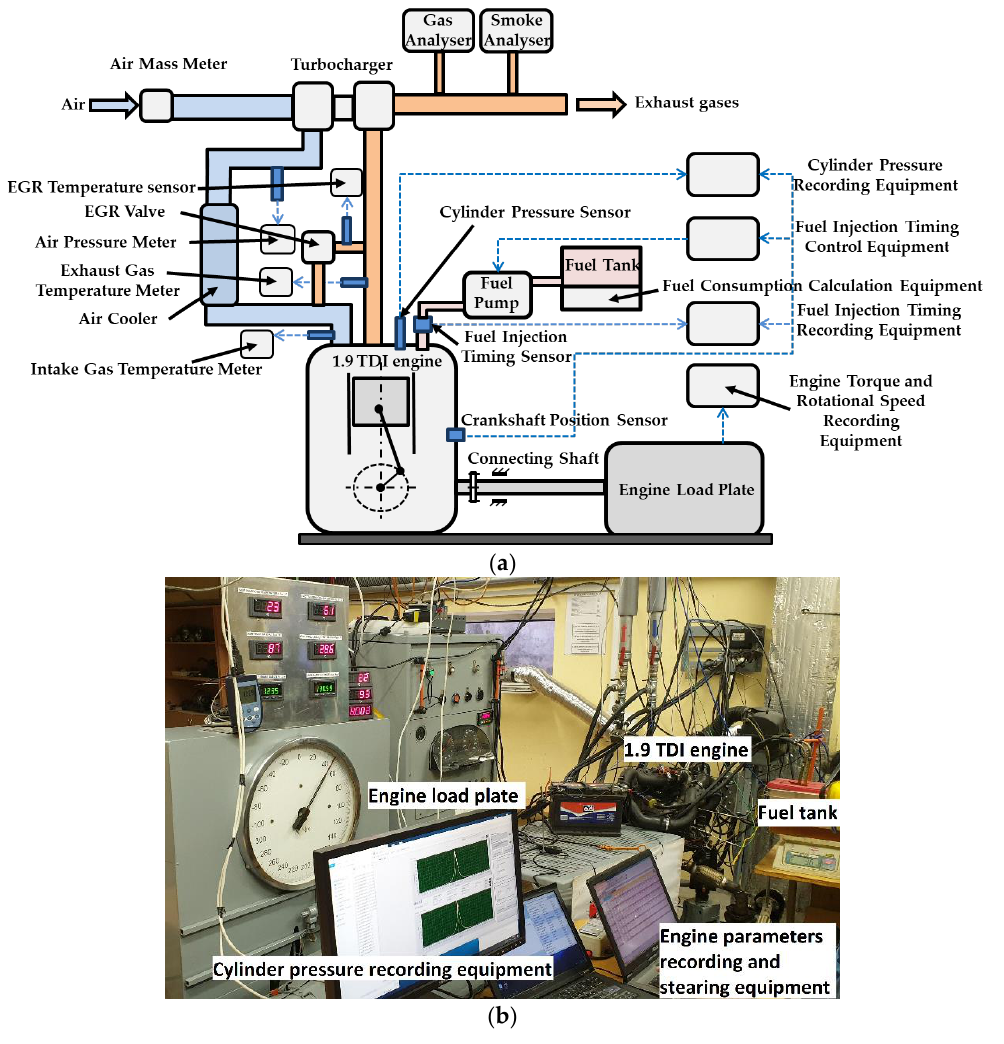
Figure 1. Image of the test engine: ( a ) test bench scheme; ( b ) test rig. Table 2. Main parameters of the 1.9 TDI diesel engine.